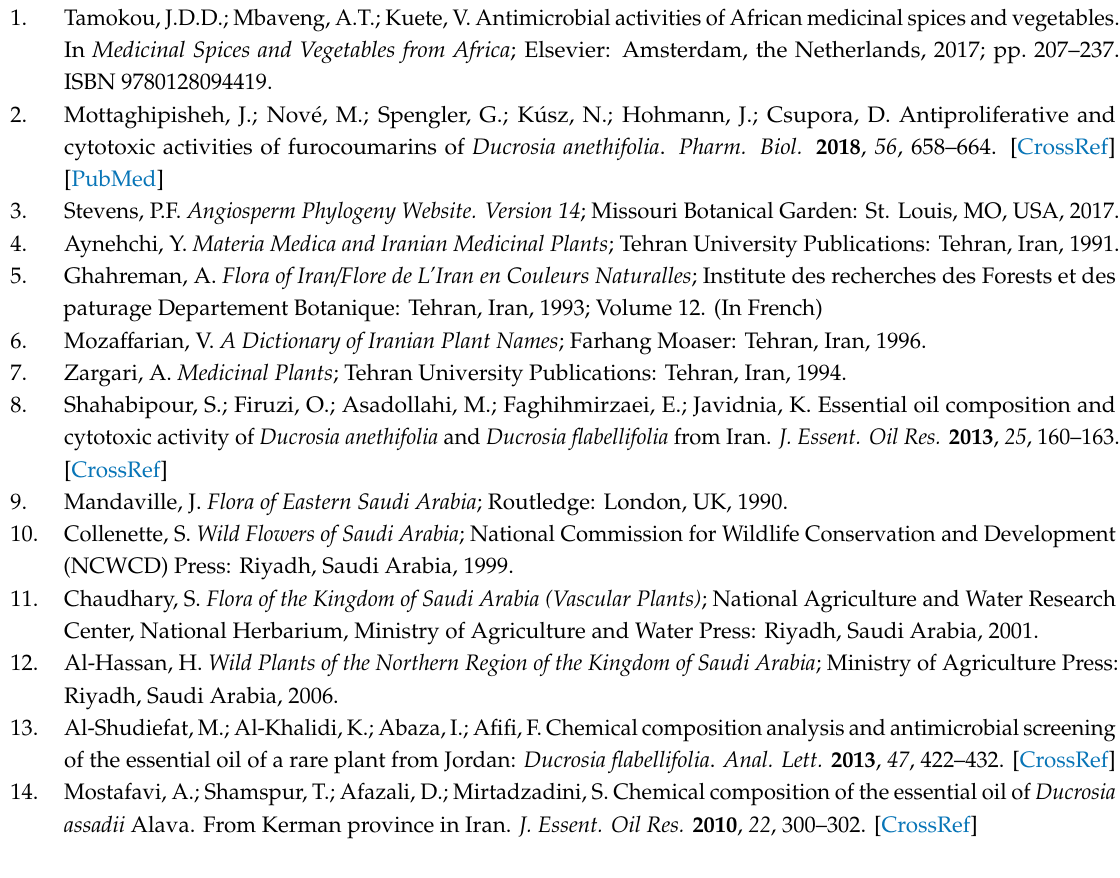
Table S1: Pharmacological and biological activities of the Ducrosia